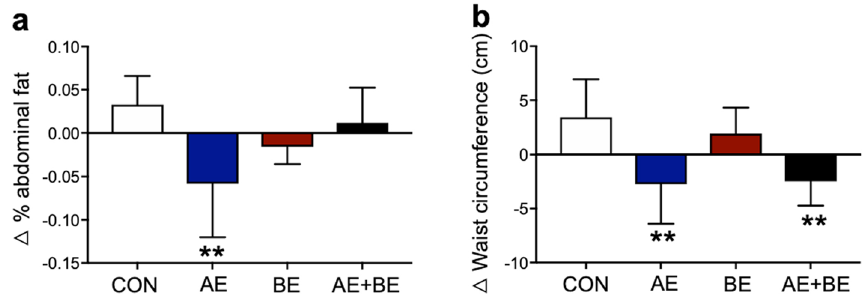
Figure 1. Changes in abdominal fat percentage and waist circumference. ( a ) Significant differences were observed between aquatic exercise (AE) and control (CON) subjects in the delta (Δ) values of % abdominal fat ( ** p < 0.01). ( b ) Significant differences were observed between AE + BE (burdock root extract) and CON subjects in the delta (Δ) value of waist circumference ( ** p < 0.01). Data are expressed as mean ± SD.